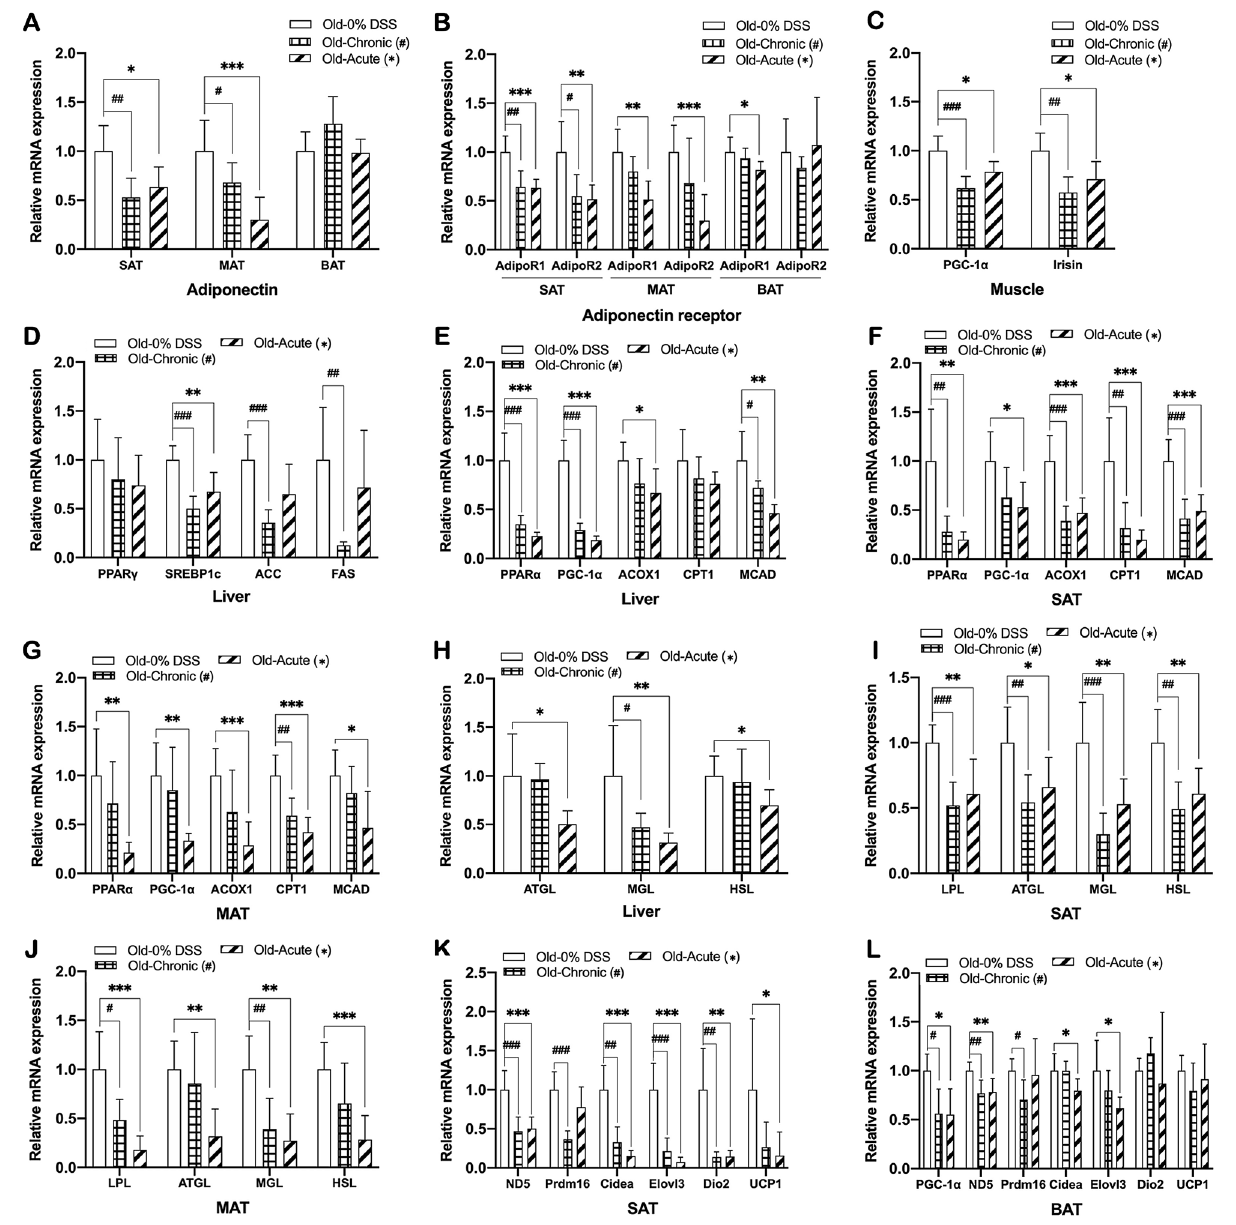
Figure 7. DSS-induced colitis older mice also have a similar molecular pathological phenotype to that found in their younger counterparts. mRNA expression of ( A , B ) adiponectin and adiponectin receptor in SAT, MAT, and BAT, ( C ) PGC-1α and irisin in the muscle, ( D ) lipogenic genes in the liver, ( E – G ) fatty acid oxidation genes in the liver, SAT, and MAT, ( H – J ) lipolytic genes in the liver, SAT, and MAT, ( K ) browning genes in SAT, ( L ) thermogenic genes in BAT of DSS-induced colitis and non-colitis 18-week-old mice. Gene expression levels are normalized to Arbp expression. Data present mean ± SD for 6–7 mice in each group. Student’s two-tailed t-test was used for the analysis of differences between experimental groups. #, * p < 0.05, ##, ** p < 0.01, ###, *** p < of DSS-induced colitis, the intestinal epithelial barrier dysfunction is associated with the disruption of tight junction proteins 45,46 , as well as mucus layer proteins 47 . Mice with DSS-induced colitis used in this study con- sistently showed decreased expression of ZO-1, occludin, MUC2, and MUC13 (Figs. 1F–H, 6G), and elevated level of plasma LPS (Figs. 1I, 6H), indicating an impairment of intestinal barrier functions and thereby increased intestinal permeability. It has been demonstrated that the loss of intestinal barrier integrity triggers a cascade of events resulting in systemic inflammation, eventually leading to both intestinal and systemic diseases including IBD and metabolic disorders 5,48 . Abnormalities in intestinal immune responses associated with impaired barrier function include an imbalance between the pro- and anti-inflammatory cytokines, which is known to play an important role in the pathogenesis of IBD 49–51 . In this study, DSS-induced colitis mice showed substantially higher levels of pro-inflammatory cytokines (Figs. 1J, 6I), a lower level of anti-inflammatory M2 macrophage (Fig. 1L),